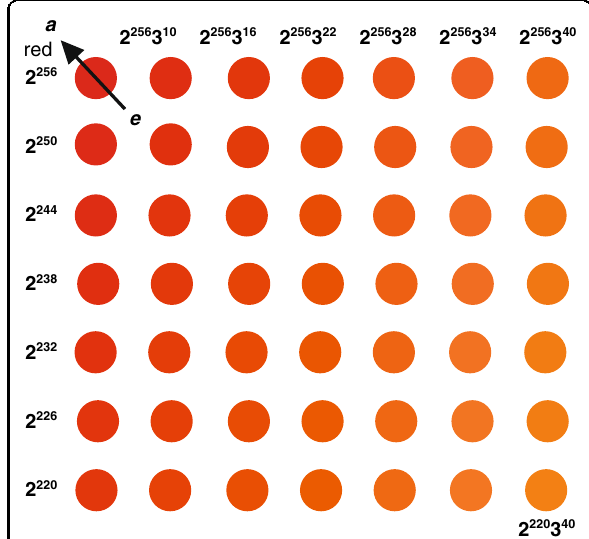
Denote w- Code( i ) as the color code of an attractor i on a